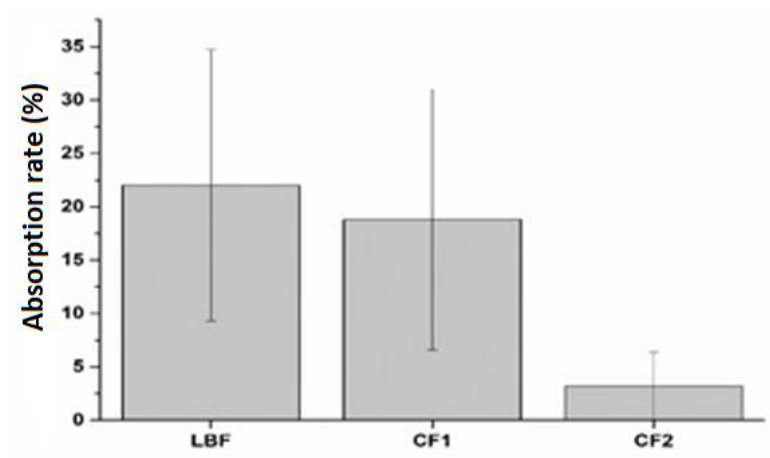
Figure 10. Absorption rate of the three formulations: LBF, CF1, and CF2. ( n = 3).